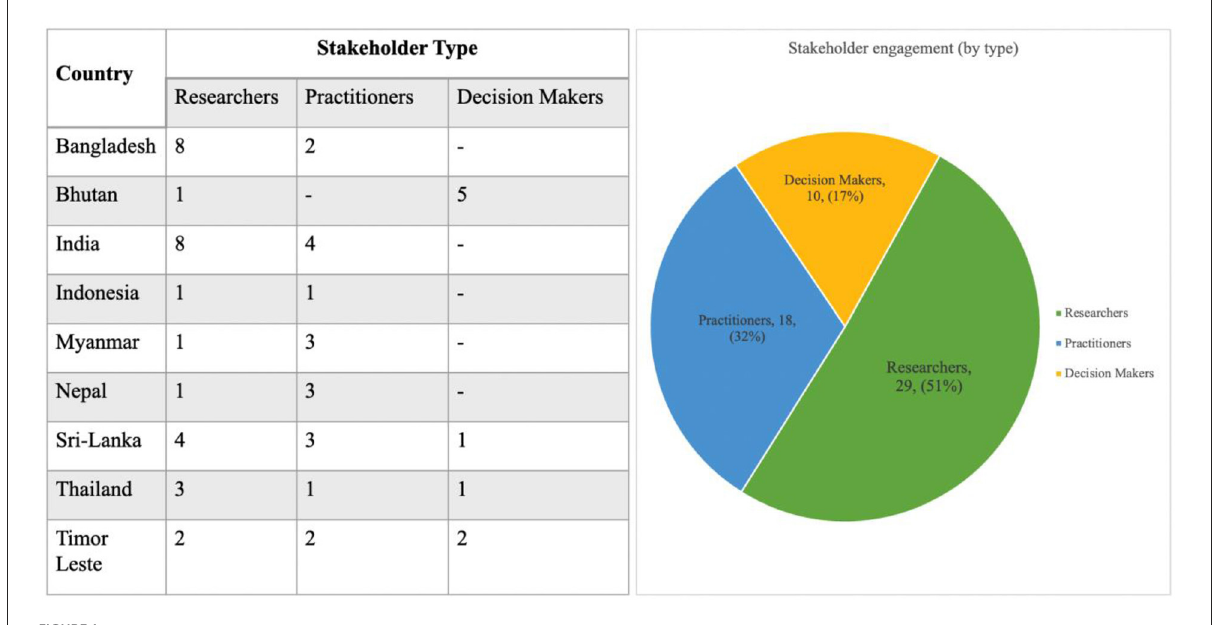
FIGURE1 Stakeholder engagement and outreach